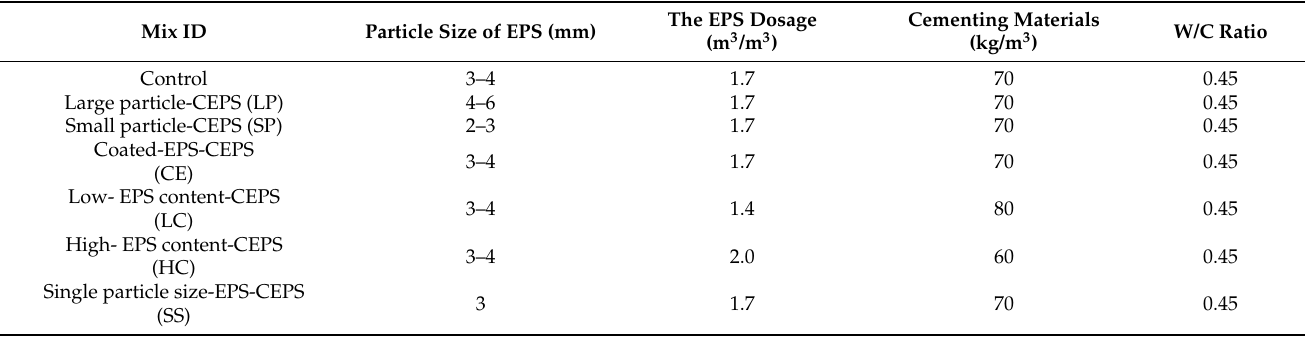
Table 1. The description of the prepared CEPS